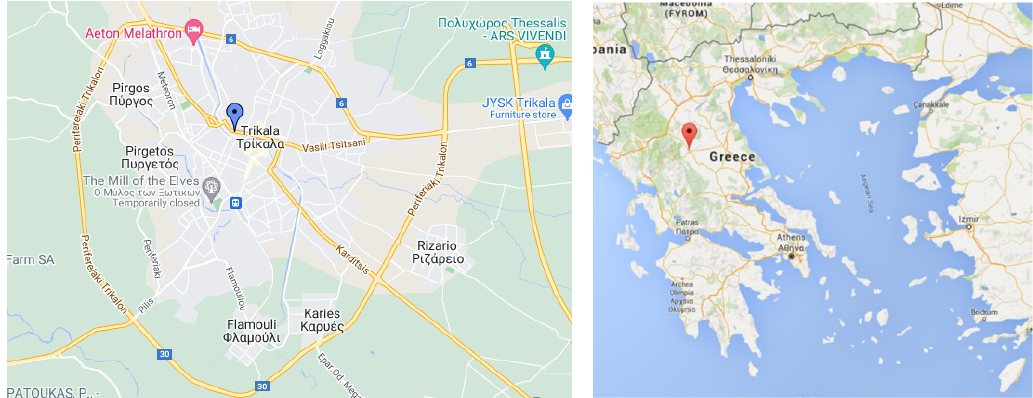
Figure 1. Topographic map of the study area [34].